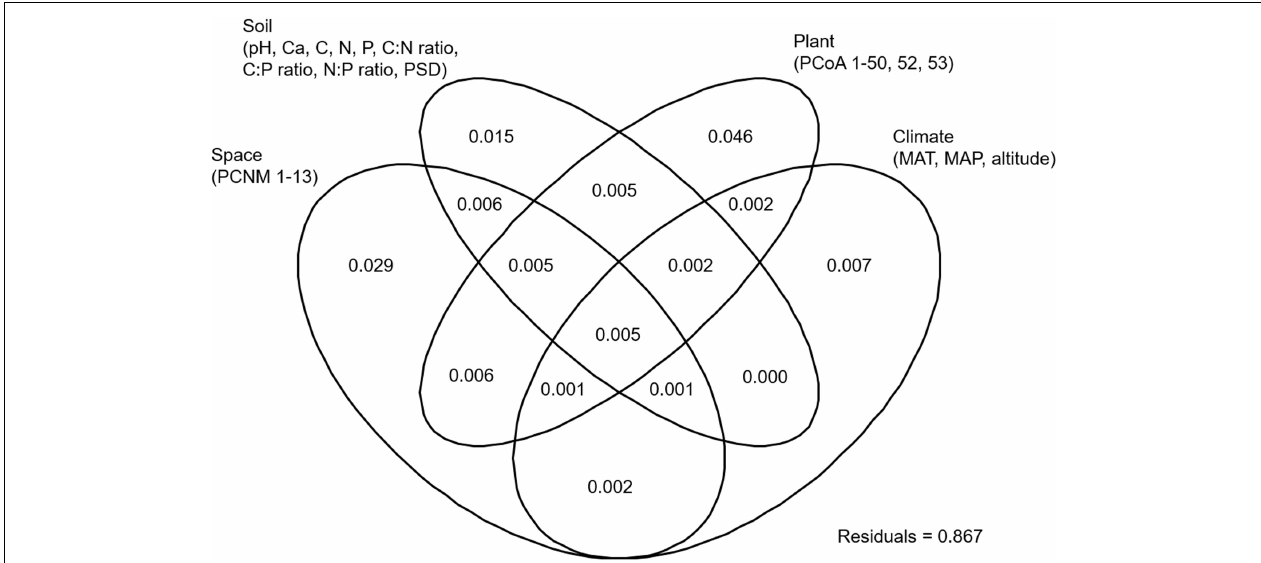
FIGURE 3 | Variation partitioning showing the pure and shared effects of host and abiotic factors on ectomycorrhizal fungal community composition. Numbers indicate the proportions of variation explained. C, total soil carbon; N, total soil nitrogen; P, total soil phosphorus; Ca, total soil calcium; PSD, particle size distribution; PCNM, principal coordinates of neighbor matrices. PCoA, principal coordinates analysis of host phylogeny; MAT, mean annual temperature; MAP, mean annual precipitation.